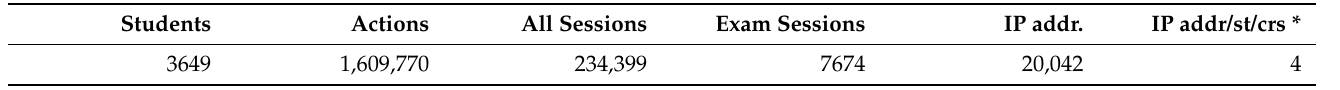
Table 1. Data about 22 courses processed for students’ cheating indication.